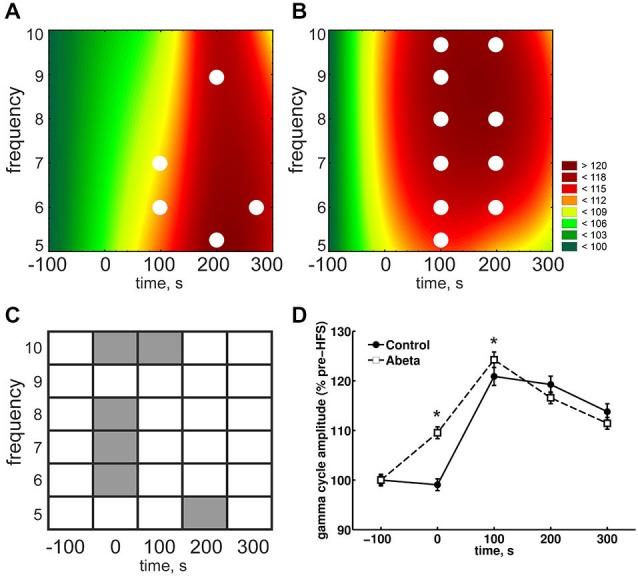
Overview of relative gamma amplitudes during each theta cycle for control and Aβ-treated animals. The mean gamma amplitudes during each cosine theta cycle (normalized to baseline) for control (A) and Aβ-treated animals (B) are shown. The color scale represents percent to the mean baseline values in A and B. The relative mean gamma amplitudes during each theta cycle are higher during HFS in Aβ-treated animals compared to control animals, as can be seen by a between-group comparison (C). This significant difference is also reflected in the pooled data (D). Both groups show the same pattern: The relative mean gamma amplitudes during each theta cycle increases till the time-point of 100 s (post-HFS) and then decays in amplitude during the following 200 s. All the same, the relative mean gamma amplitude at time point 100 s in the Aβ-group is significantly higher compared to controls. Within-group statistical analysis revealed that the relative mean gamma amplitudes are higher at all theta cycle frequencies at time-point 100 s for Aβ-treated animals (white marks in B) but not for controls (white marks in A). Within-group comparison for the pooled data (C) showed that the relative gamma amplitudes are higher compared to baseline only for Aβ-animals. White dots in (A) and (B) reflect significantly different values compared to baseline according to the Kruskal-Wallis-Test with Bonferroni corrected Tukey-based post hoc analysis.